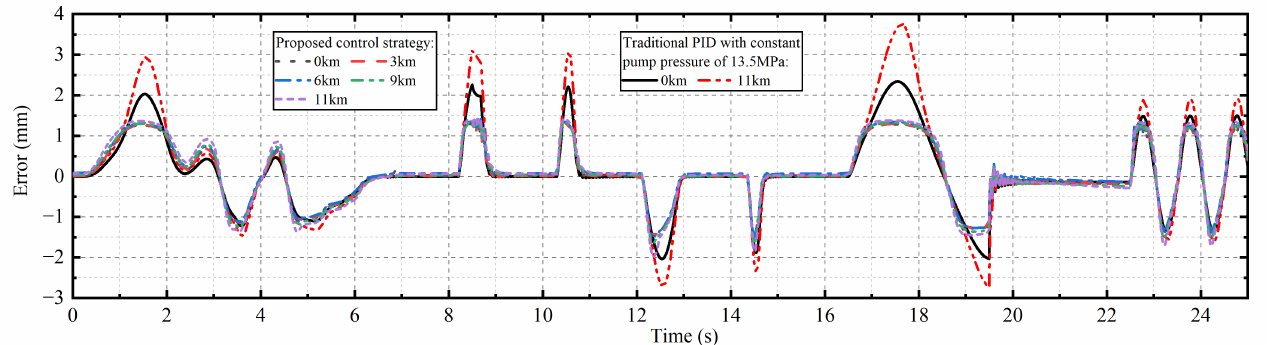
Figure 16. Tracking performance of complex movement.